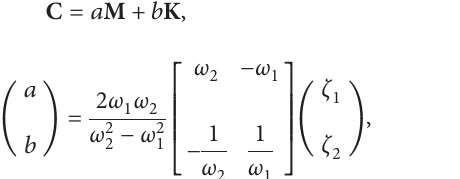
Figure 9: 2D of parametric